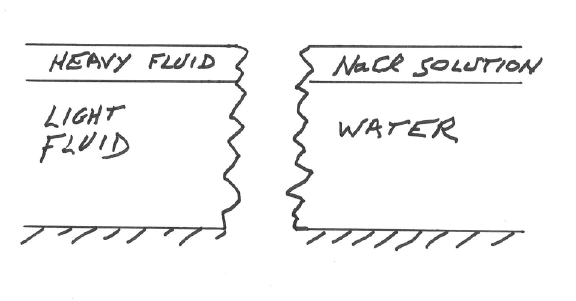
Fig. 4: A Rayleigh-Taylor instability consists of a relatively dense fluid layer above a less-dense fluid layer.